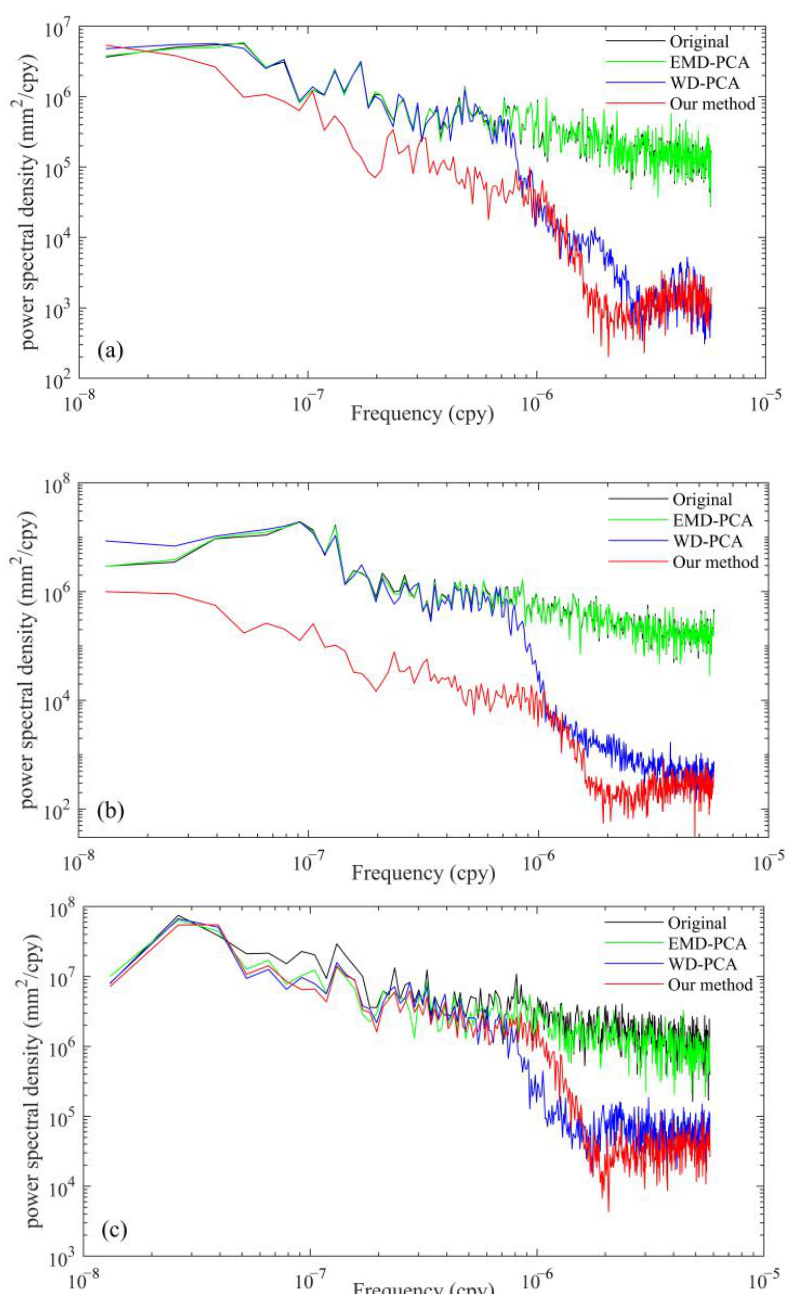
Figure A2. Decomposed results of the denoised GNSS data in N component at the P242 station based on WD ( a ), EMD ( b ), and CEEMD ( c ), respectively.